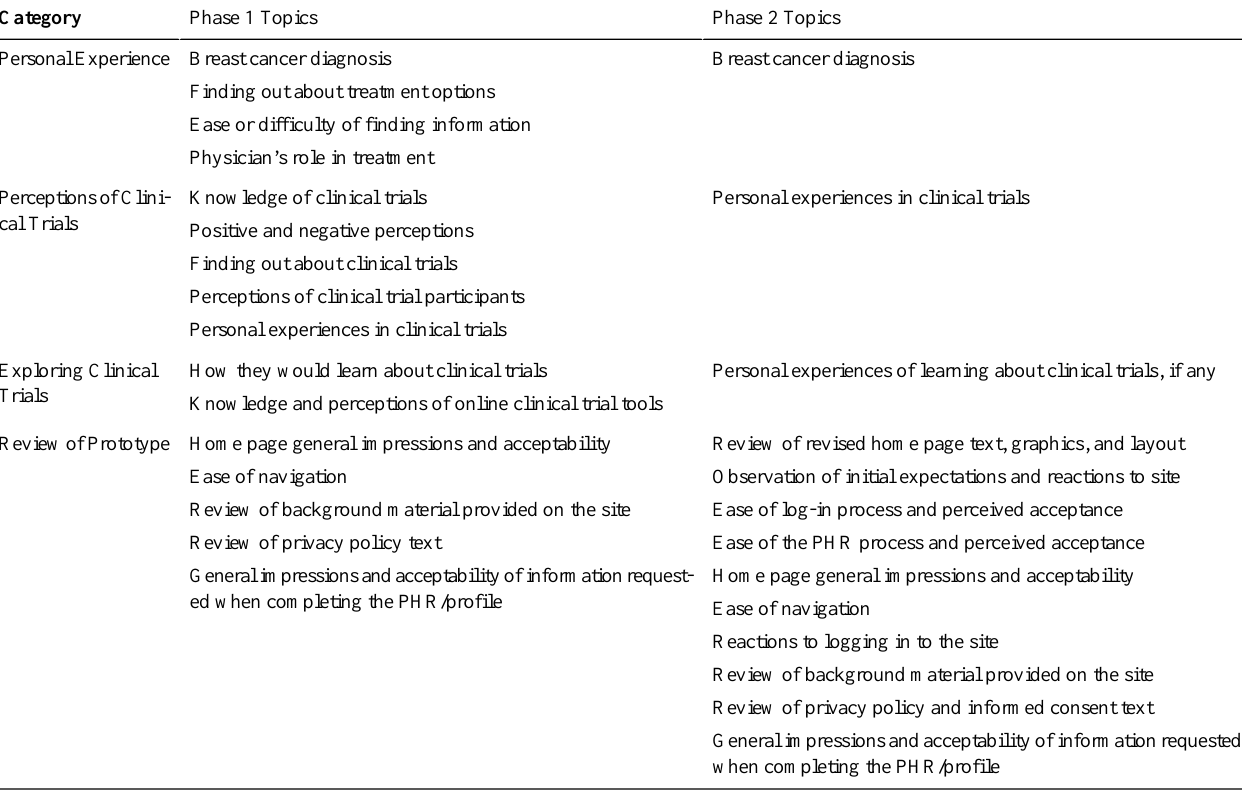
Table 1. Discussion topics by research phase and